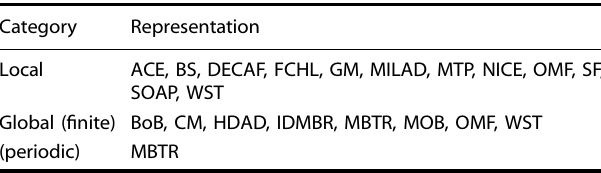
Table 3. Types of representations. Table 4. Overview of